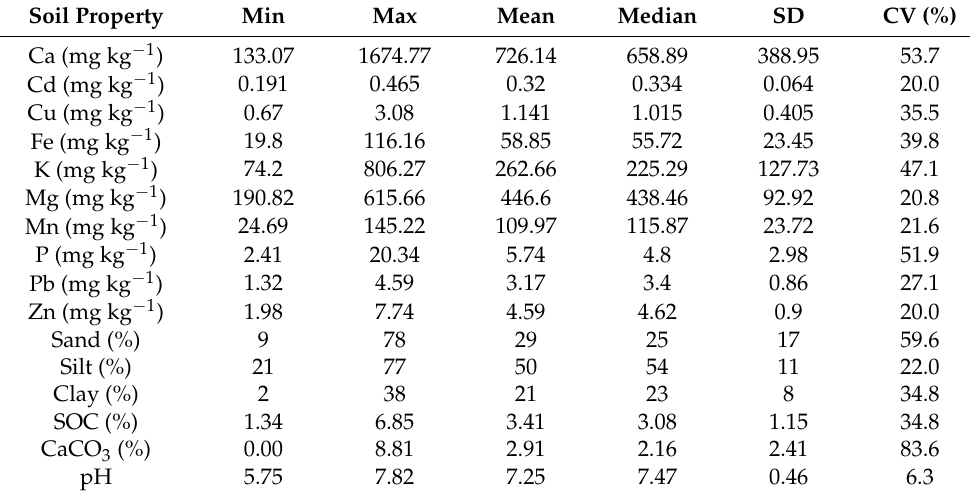
Table 1. Descriptive statistics of the tested soil properties.